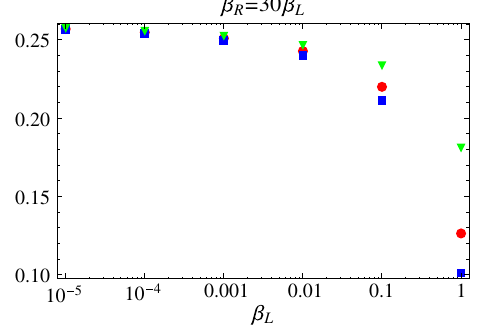
FIG. 4. Verification of the inequalities Eq. (3) in the sinh- Gordon model. Displayed are the functions β 2 β 2 ð e L − e R Þ = 2 (triangles), and β 2 L